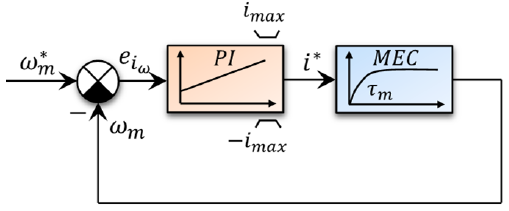
Figure 8. Block diagram of the simplified speed loop.